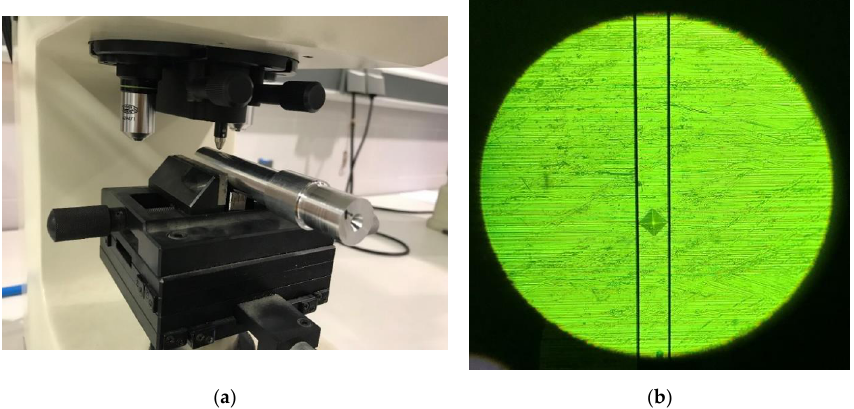
Figure 3. ( a ) Hardness test set-up; ( b ) generated mark in the test point .